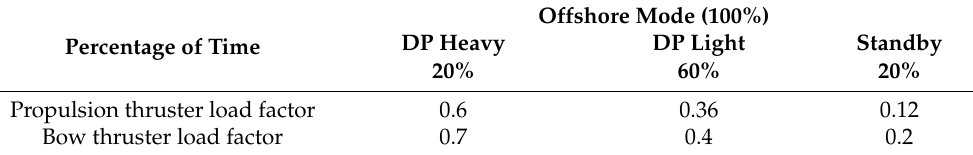
Figure 8. Generic speed profiles against cumulative time for MPSV. Table 3. Offshore mode definition.